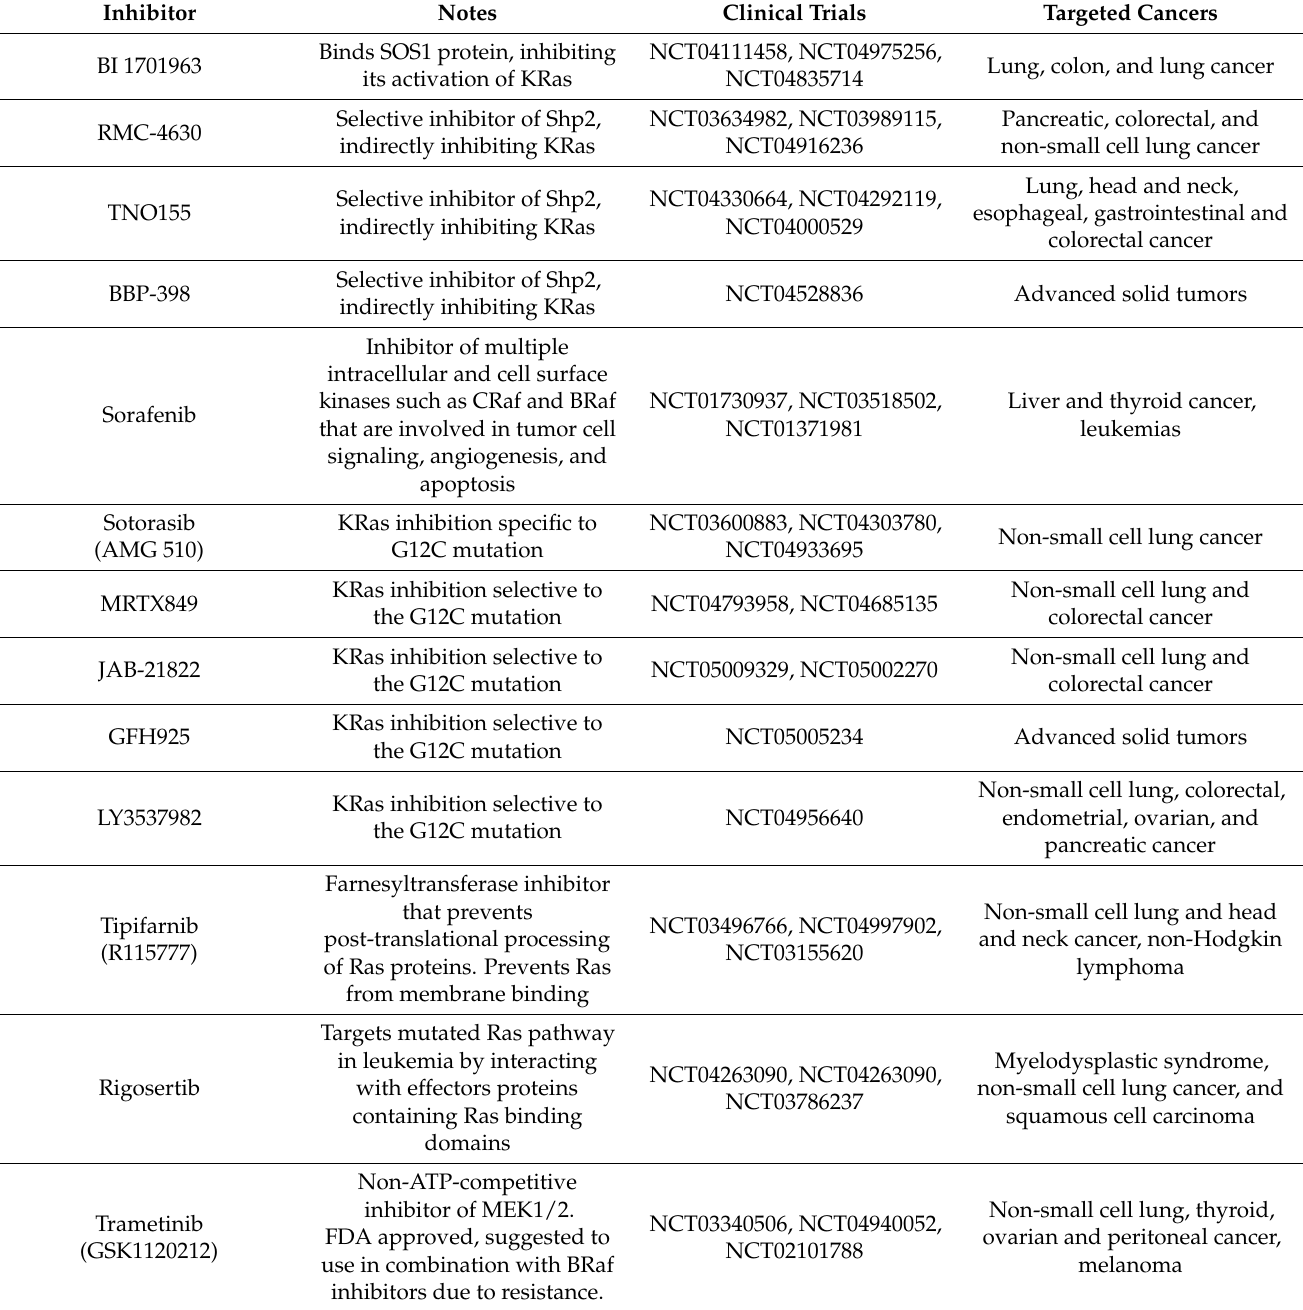
Table 3. Inhibitors of MAPK cascade in active clinical